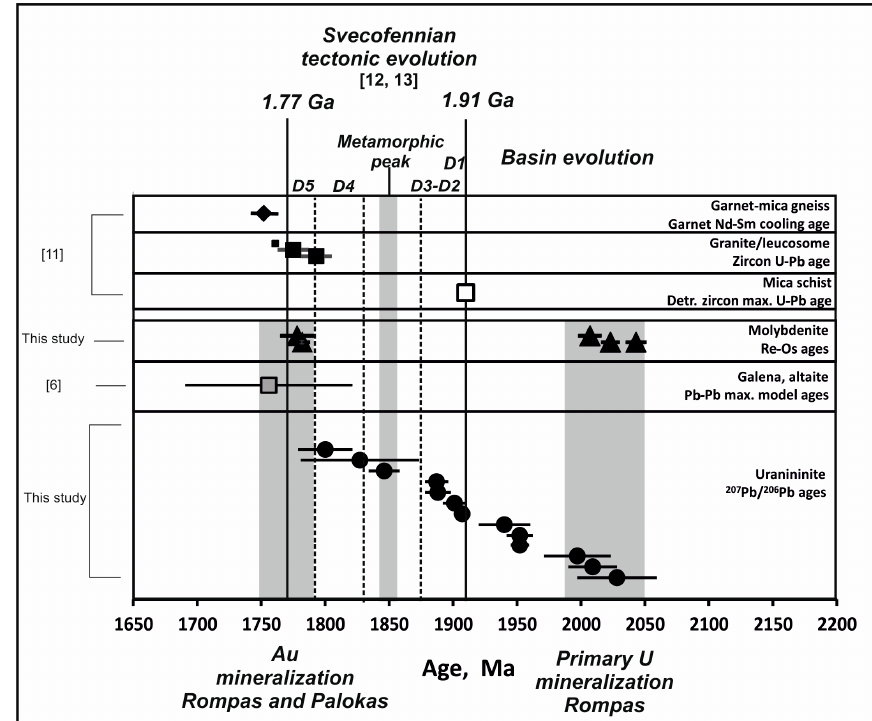
Figure 9. Comparison of results of U–Pb dating of uraninite ( 207 Pb/ 206 Pb ages) and Re–Os dating of molybdenite with data from other geochronological studies completed near the Rompas and Palokas prospects, and comparison of these data with the ages for the major tectonic stages of the Svecofennian orogeny.